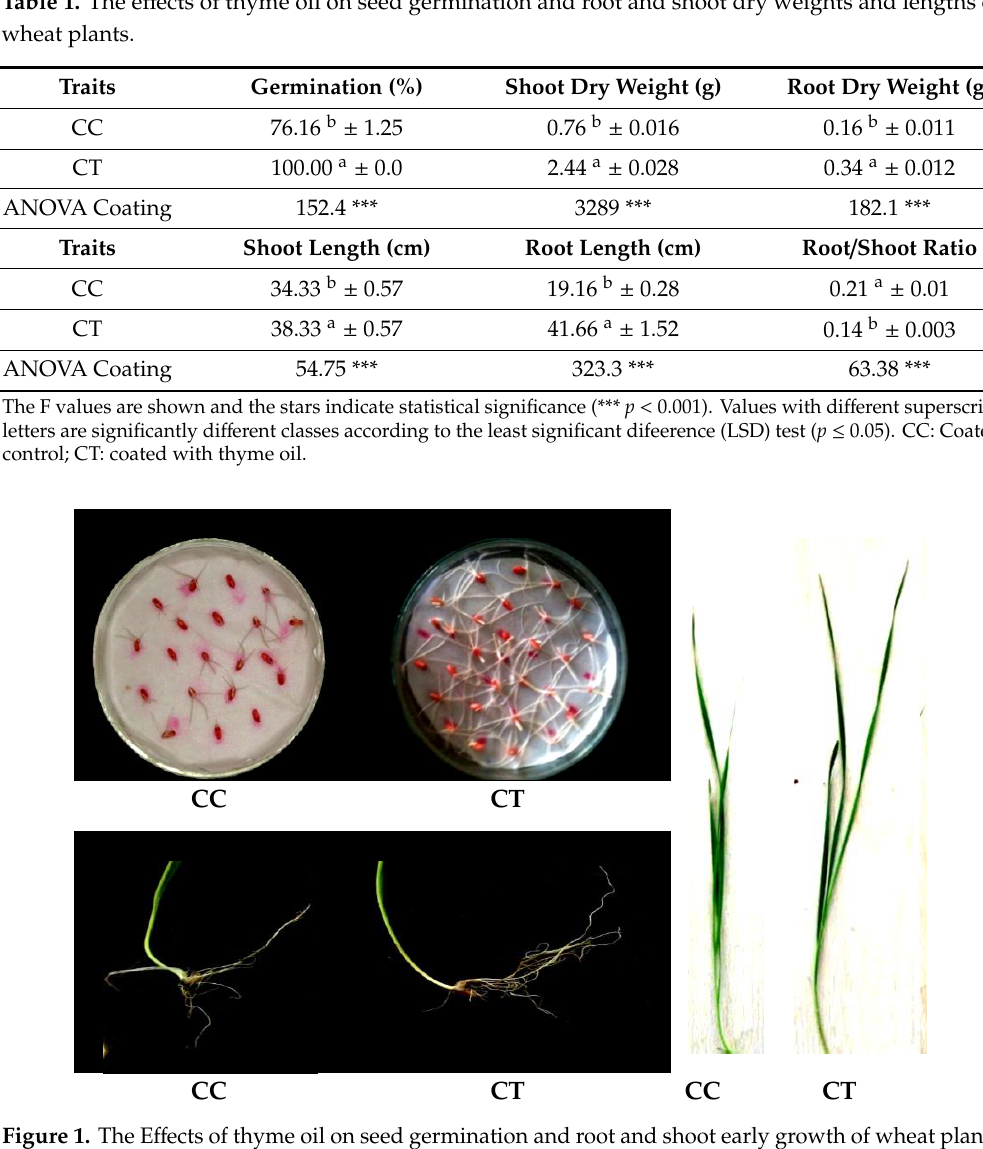
Table 2. Water content and nutritive supply at different time points of the pots submitted to the water and nutrient stress.